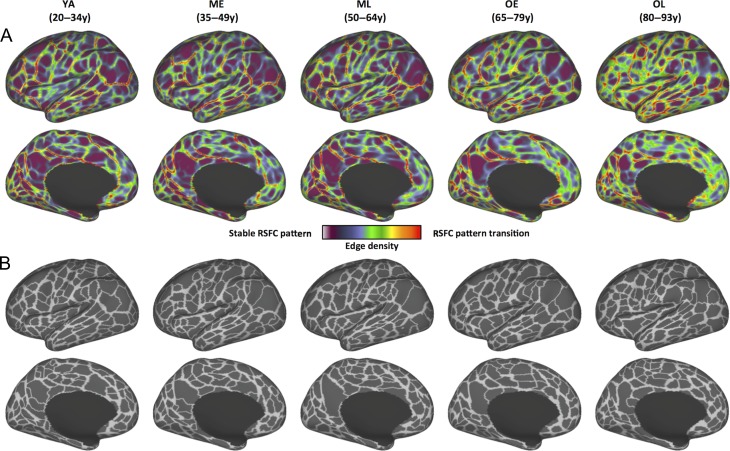
RSFC-based boundary maps and parcellation maps using the combined dataset. Datasets 1 and 2 were combined to create a final set of boundaries and parcellation maps. (A) RSFC boundary maps of 5 age cohorts: brighter colors indicate higher probability of RSFC pattern transition (i.e., a putative area boundary). Darker colors correspond to vertices with stable RSFC patterns (i.e., less likely to be area boundaries). (B) Functional parcels of 5 age cohorts, calculated from their corresponding boundary maps. Lateral and medial views of the left hemisphere are depicted here; see Supplemental Information (Fig. S4) for right hemisphere views and maps of boundary overlap.